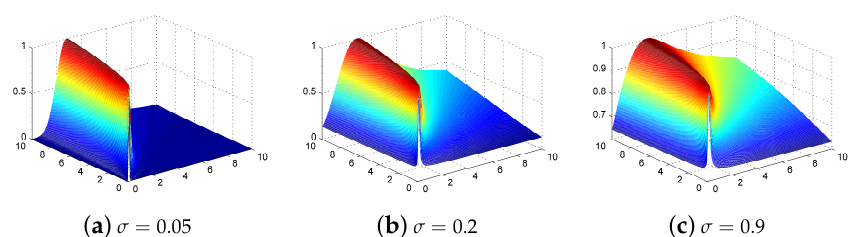
Figure 4. Normalized-SID-RBF kernel representation with parameter σ values of ( a ) 0.05, ( b ) 0.2, and ( c )